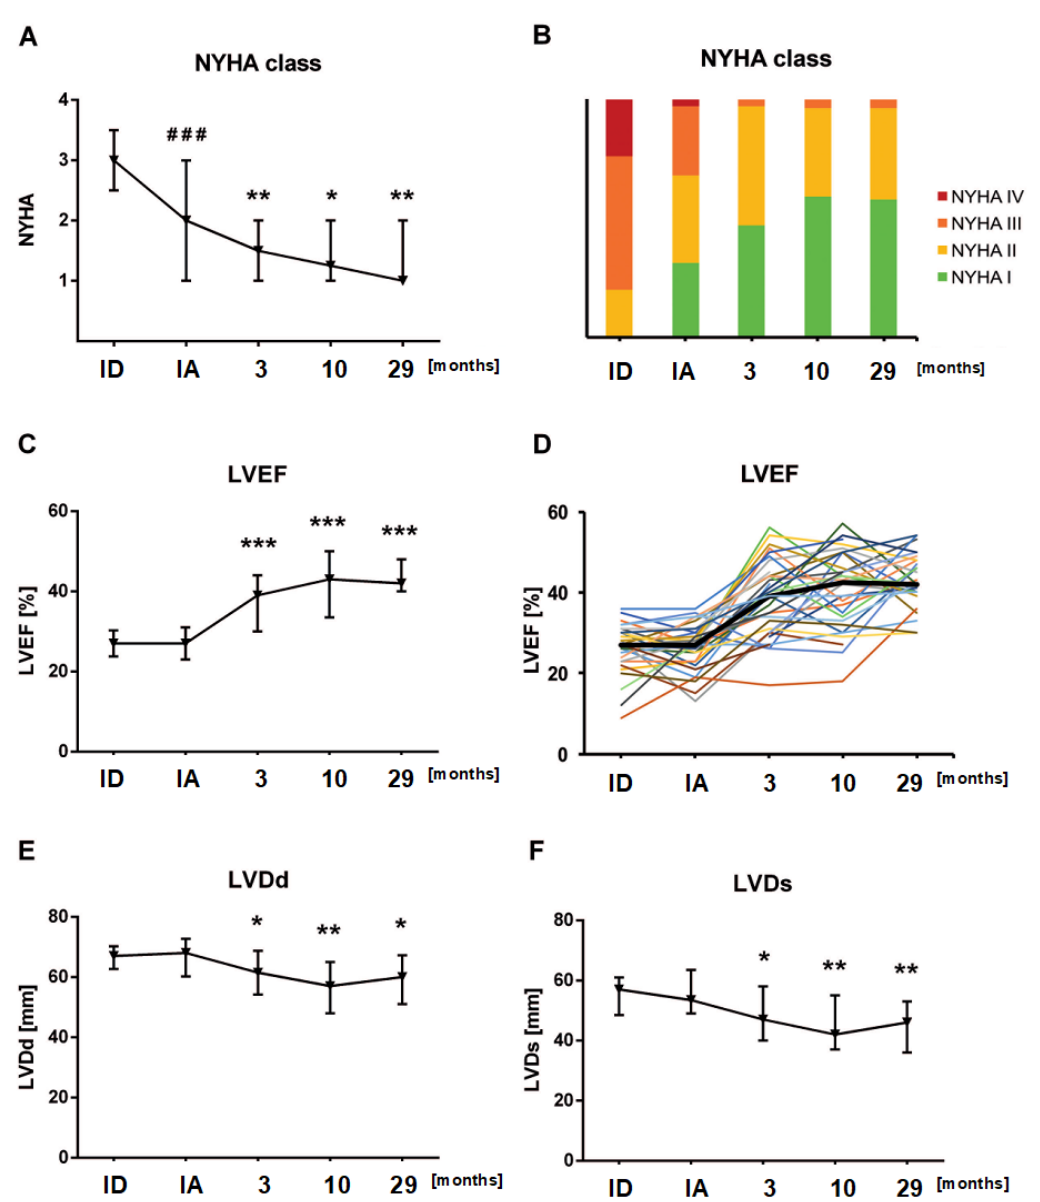
Figure 2. Change of clinical outcome and cardiac performace parameters. Time course of ( A , B ) NYHA functional class, ( C , D ) left ventricular ejection fraction (LVEF), ( E ) LVDd and ( F ) LVDs are analyzed. Hashes represent significance between initial diagnosis (ID) and immunoadsorption (IA). Asterisks represent significance level between IA and follow-up visits (FU). (### p < 0.0001; * p < 0.05, ** p < 0.005, *** p < 0.0001).